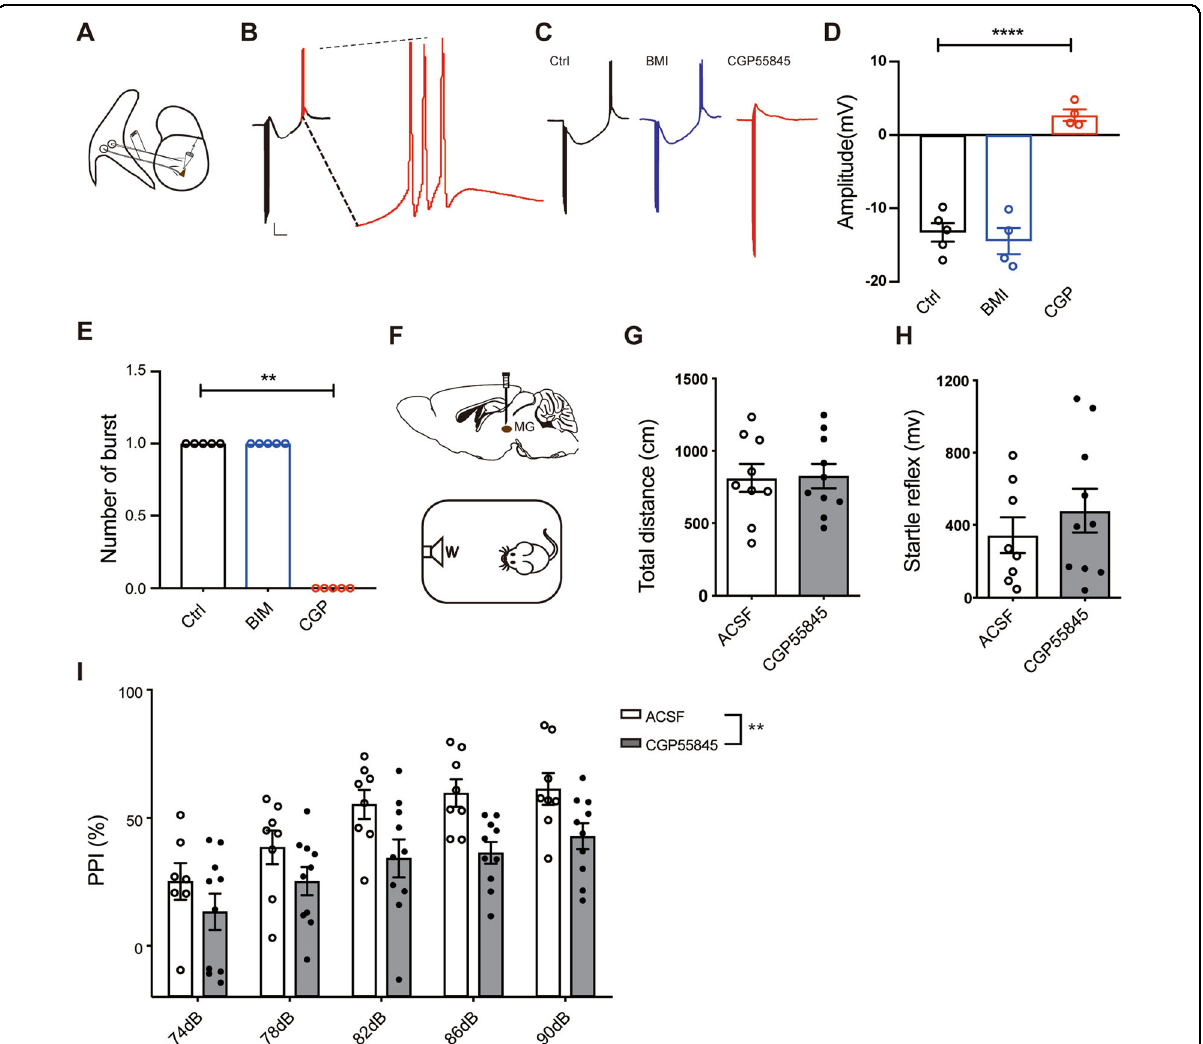
Fig. 5 Inhibition of GABAB receptor prevents rebound bursting in the MG and impairs PPI performance. A Electrophysiological recording in MG slice of PV-cre: Ai14 mice. A stimulating electrode was placed in the audTRN fi ber path. The electrical stimulation frequency was 300HZ. B Left, example of burst fi ring induced by electrical stimuli of the inhibitory audTRN – MG pathway. 100 μ M APV and 20 μ M CNQX were used to block excitatory input. The amplitude of hyperpolarization was calculated between two dotted horizontal lines. Right, enlarged trace from the dotted line area in the left trace. Scale bars: 100 ms, 10 mV. C Example trace of rebound burst fi ring without drug treatment (left, group control ), with GABAA receptor antagonist 20 μ M BMI treatment (middle, blue, group BMI ), or with GABAB antagonist 0.5 μ M CGP55845 treatment (right, red, group CGP ). D , E Hyperpolarization and rebound burst fi ring were blocked by GABAB receptor antagonist but not by GABAA antagonist ( D amplitude of hyperpolarization, group control versus group CGP , Student ’ s t -test, t 7 = 10.110, P < 0.0001; E number of burst fi ring, group control versus group CGP , Mann – Whitney two-tailed t -test, P = 0.0079, N = 5 cells). F Schematic of pharmacology experiment. Cannulas were unilaterally implanted into MG of C57 mice. After 7 days recovery, mice were given 0.1 mM CGP55845 or ACSF 30 min before OFT and PPI paradigm. G , H Infusion of 0.1 mM CGP55845 to MG of mice had no effect on total distance in OFT (Student ’ s t -test, t 17 = 0.103, P = 0.9190, N ACSF = 9 mice, N CGP = 10 mice) or startle re fl ex in PPI (Student ’ s t -test, t 16 = 0.834, P = 0.4163, N ACSF = 8 mice, N CGP = 10 mice). I Infusion of 0.1 mM CGP55845 to MG of mice impaired PPI performance (two-way ANOVA, F (1,80) = 8.733, P = 0.0041, N ACSF = 8 mice, N CGP = 10 mice). ** P < 0.01,**** P <